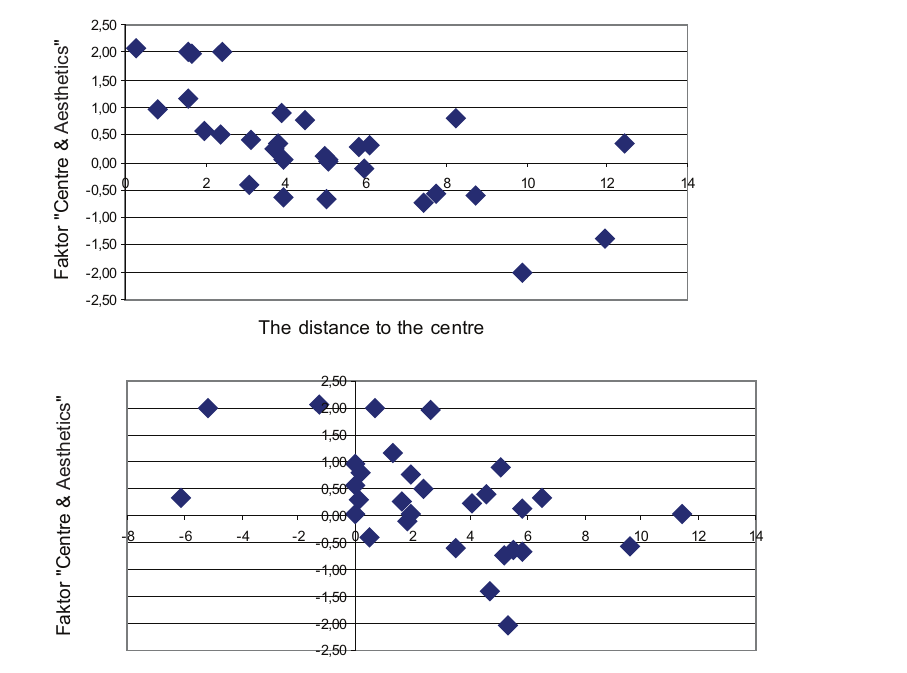
figure 4. General shift in changes of the “centre & aesthetics” factor, the distance to the centre and green areas